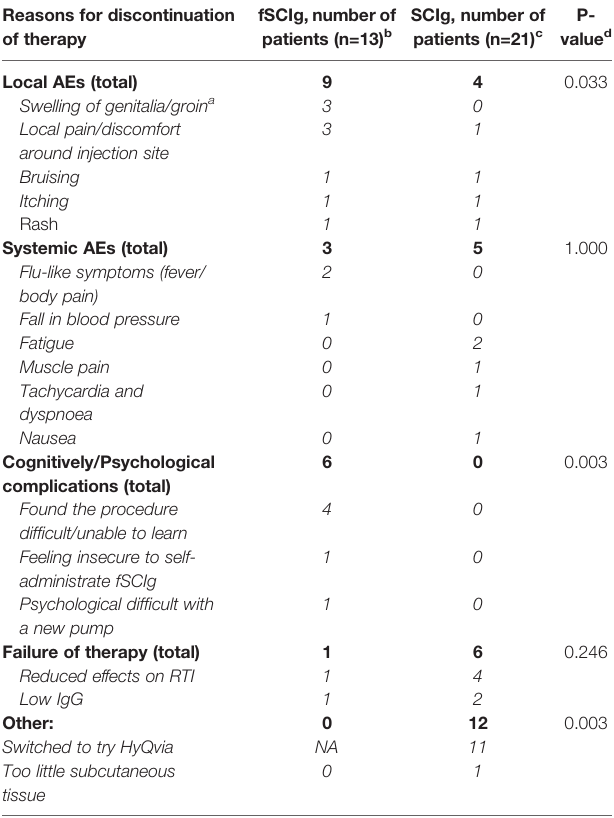
TABLE 2 | Reasons for discontinuation of fSCIg and SCIg from 2017-2019. Reasons for discontinuation of